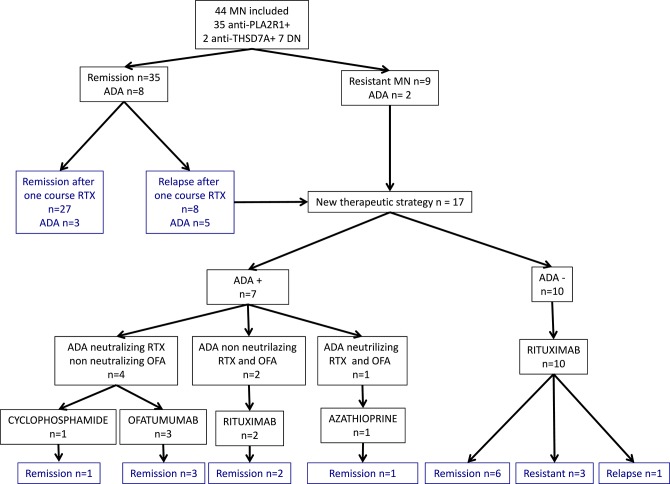
Primary membranous nephropathy cohort and outcomes. Flow chart of 44 primary membranous nephropathy patients and outcome after rituximab therapy. MN, membranous nephropathy; DN, double negative; ADA, Anti-Drug Antibodies; RTX, rituximab; OFA, ofatumumab.